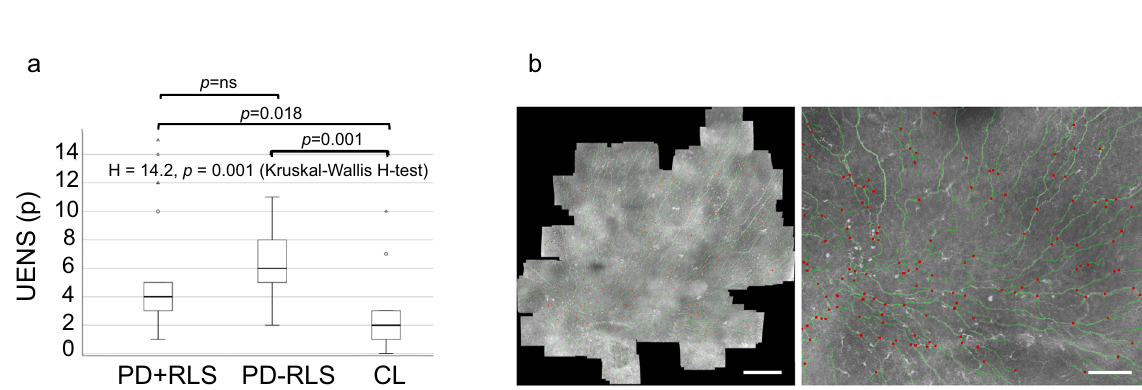
Fig. 1 Group comparisons of UENS scores and representative mosaic image of the corneal subbasal nerve plexus. Comparison of UENS scores ( a ) between study groups. Boxplot showing center line (median), interquartile range (box length), whiskers (1.5 × interquartile range) and outliers. b Left: mosaic image from patient with PD and RLS showing traced nerve paths. Scale bar = 500 μ m. Right: magni fi ed region showing detailed nerve paths (green) and branching points (red). Scale bar = 100 μ